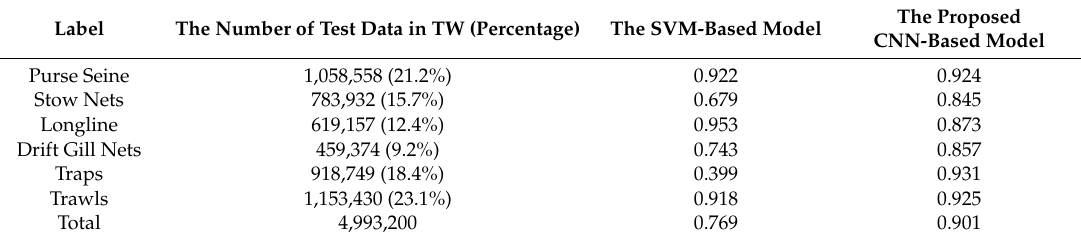
Table 5. TPI scores for the SVM-based and the convolutional neural network (CNN)-based model.